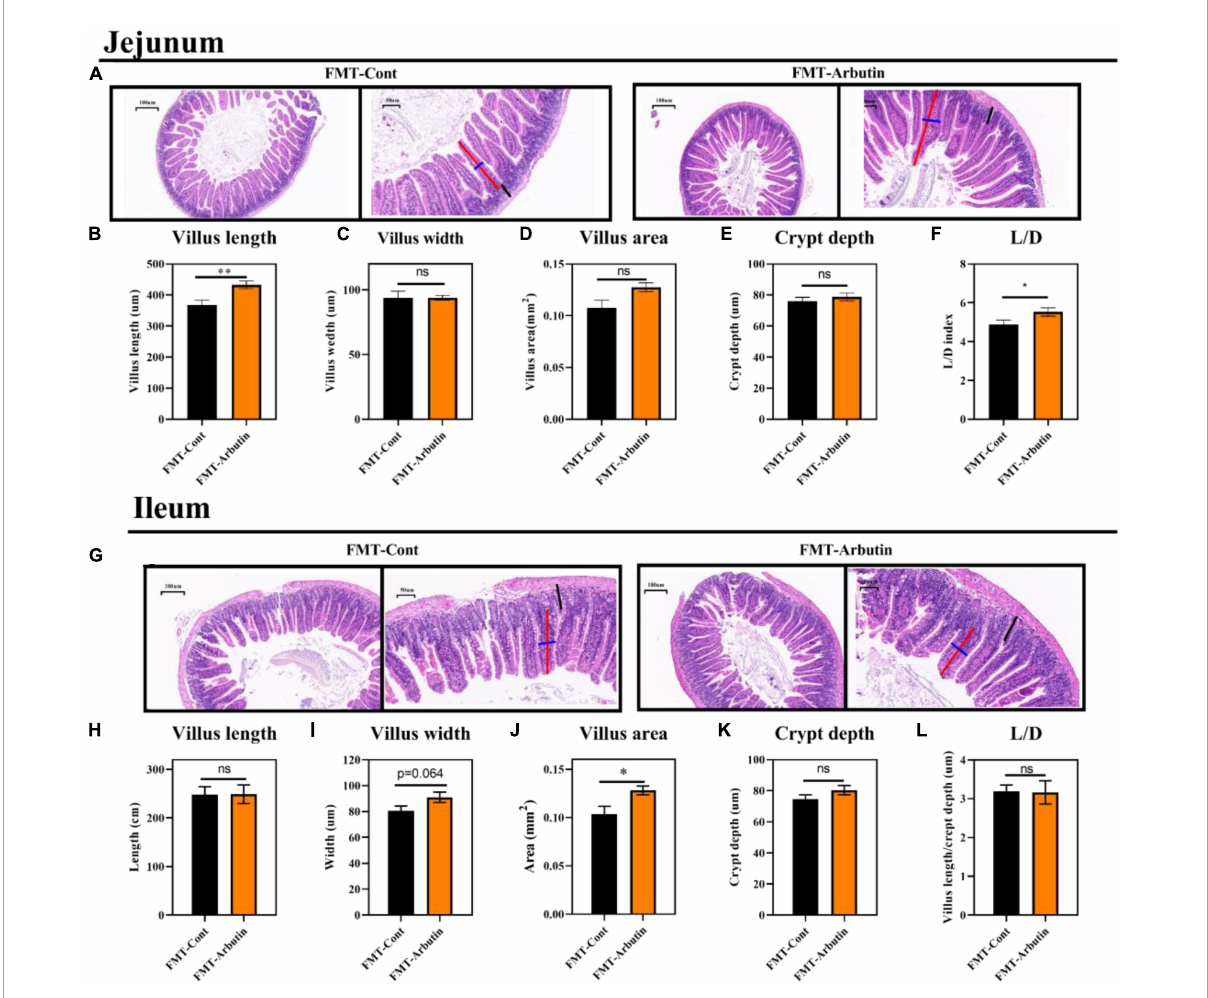
FIGURE6 Fecal microflora transplantation improved gut development in mice. HE staining of the jejunum (A) , villus length in the jejunum (B) , villus width in the jejunum (C) , villus areas in the jejunum (D) , crypt depth in the jejunum (E) , L/D in the jejunum (F) , HE staining of the ileum (G) , villus length in the ileum (H) , villus width in the ileum (I) , villus areas in the ileum (J) , crypt depth in the ileum (K) , and L/D in the ileum (L) ( n = 10). Differences were assessed by t -test and denoted as follows: ∗ P < 0.05, ∗∗ P <